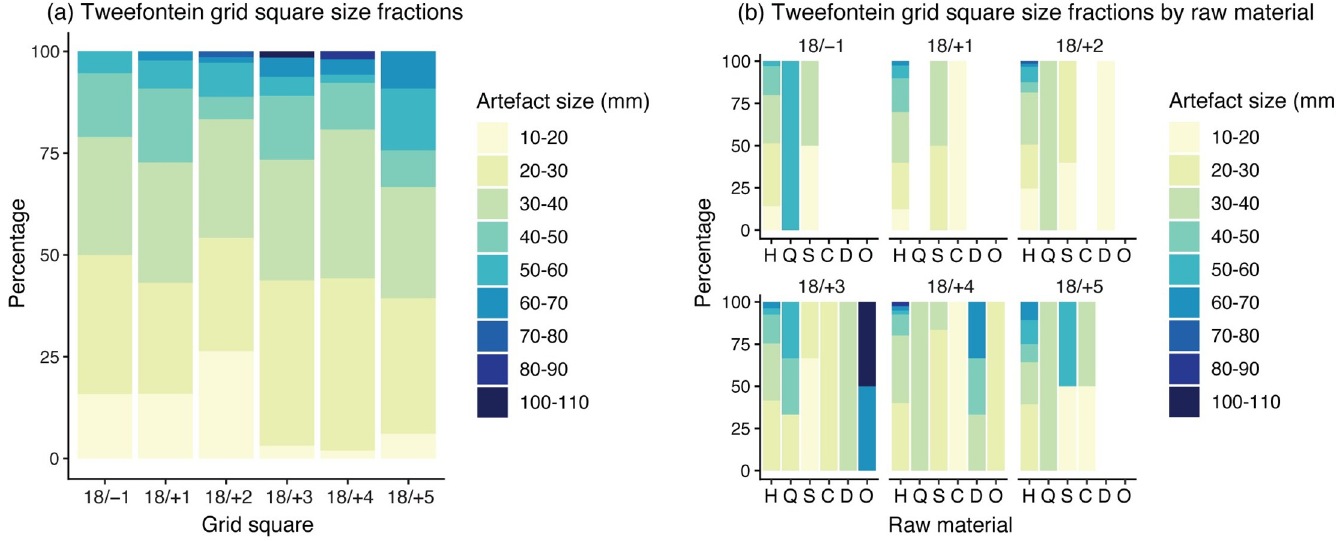
Fig 5. Bar graphs showing artefact size fractions in the sampling grid. (a) By grid square, (b) by raw material. Grid squares refer to column 18 and row number (see Fig 4); raw material abbreviations H hornfels, Q quartzite, S silcrete, C CCS, D dolerite, O other.